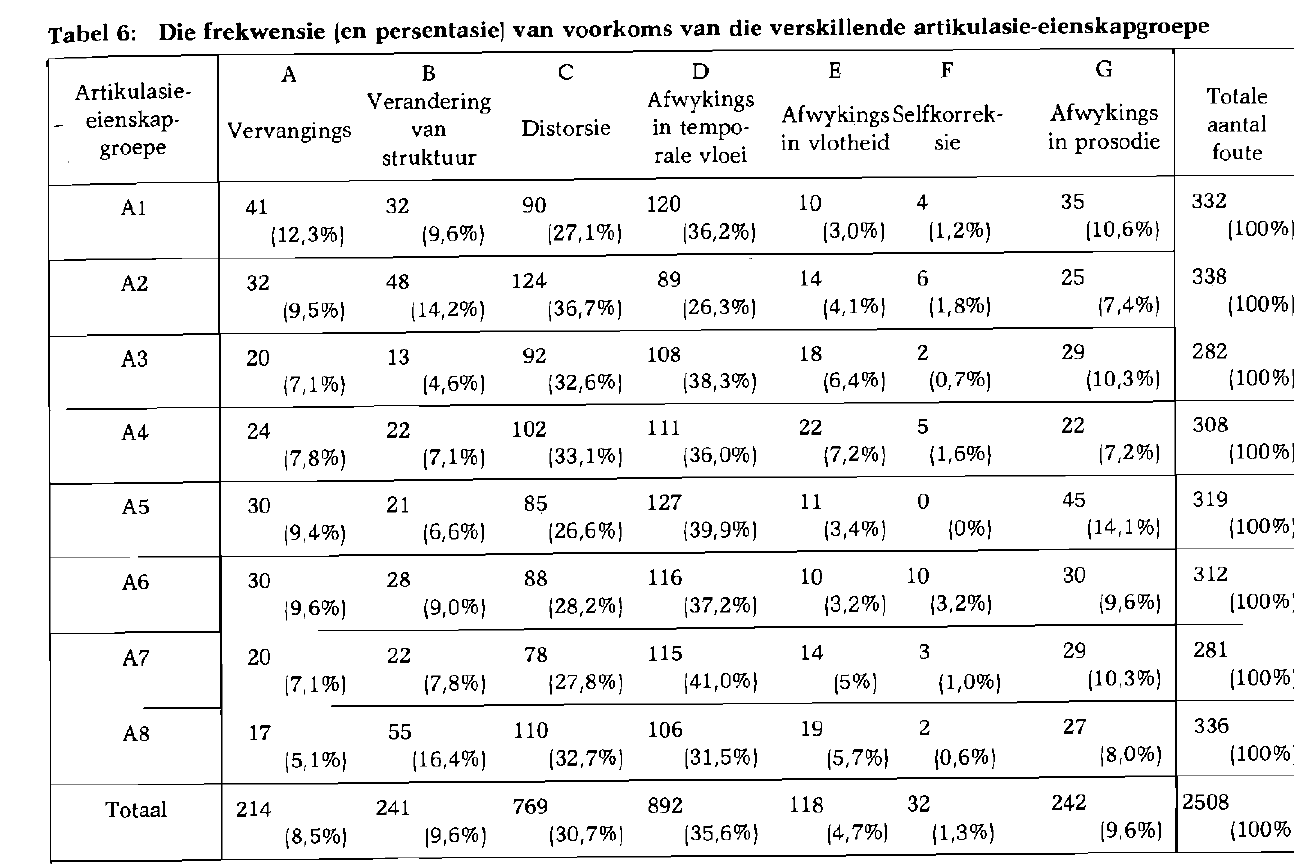
Die afleiding kan egter nie gemaak word dat